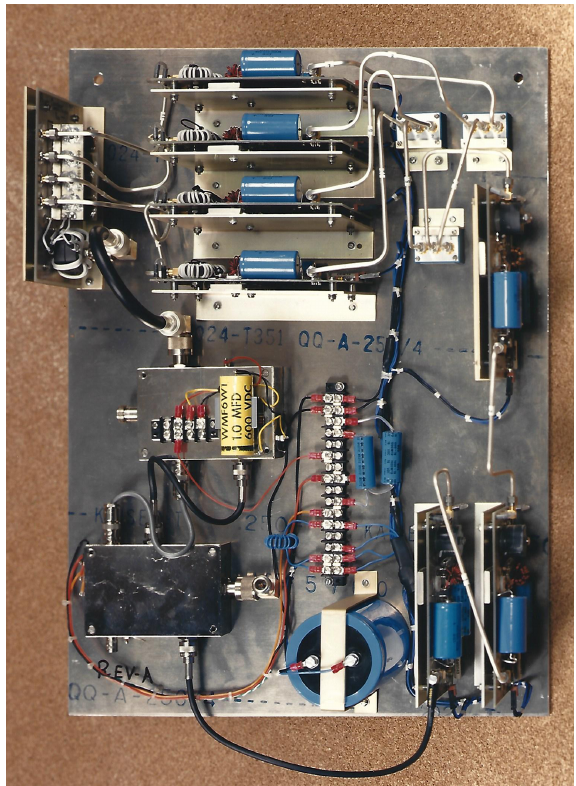
Figure 2. Photograph of one of the upgraded 800W transmitters as they appeared in their galvanized steel containers. A total of four 200W amplifier modules are stacked at the top of the plate, and their outputs are summed in the power combiner to the left. The output of the power combiner is connected to the high-power T/R switch. During transmission, the forward power is directed to the open con- nector on the high-power switch, which is connected via cable to the antenna. On reception, the signals received by the antenna enter the high-power switch through the open connector and exit it through the connector immediately under the yellow capacitor. It then passes through the low-power switch, the phasing matrix, and back to the receiver in the control building. This photo was produced by the photography group at JHU/APL in 1986. It is identified as photo no. 220592.